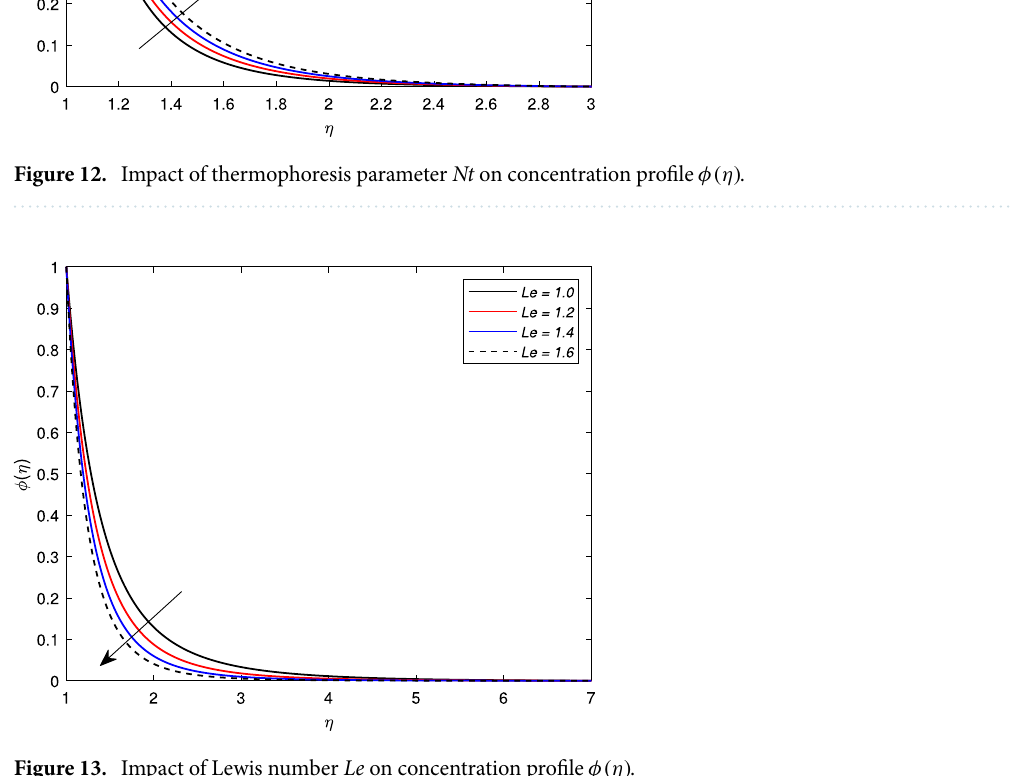
Figure 13. Impact of Lewis number Le on concentration profile φ(η)